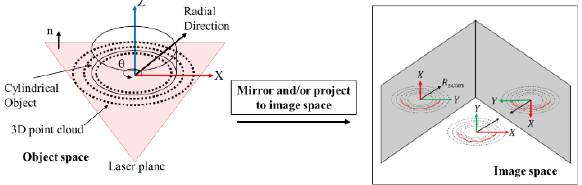
Figure 5: Object space 3D point cloud definition and mirroring/projection to image